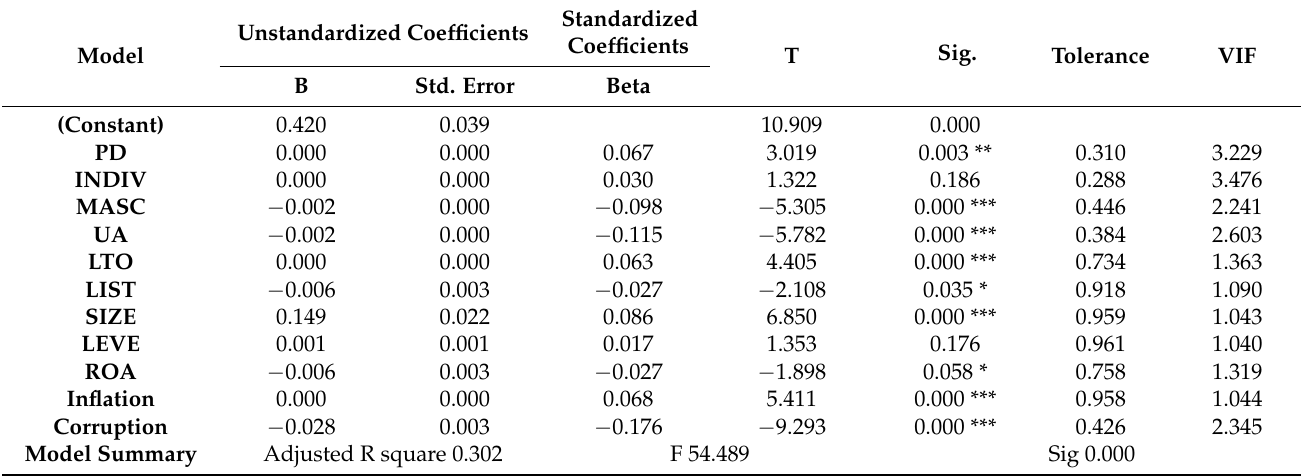
Table 7. Model 4: Impact of inflation and corruption on the affiliation between culture and cash holdings. Unstandardized Model